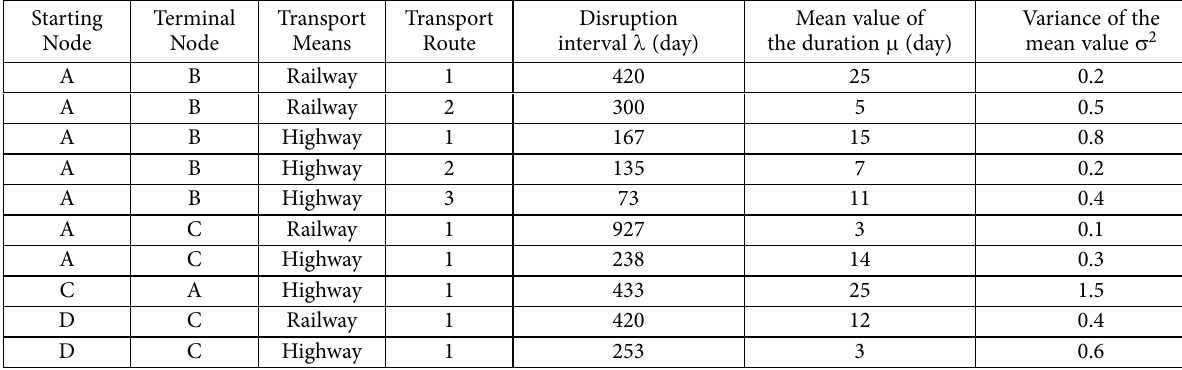
Table 2. Disruption parameters regarding P ( l ) and N ( m , s 2 ) for the 10 transportation lines